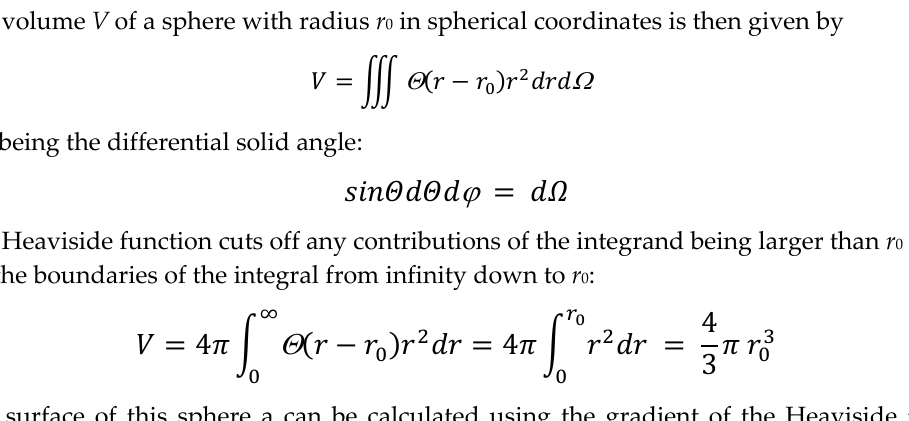
Figure 1. Scheme of the Heaviside function Θ ( x ). This function takes the value 1 wherever the object/sphere is present and 0